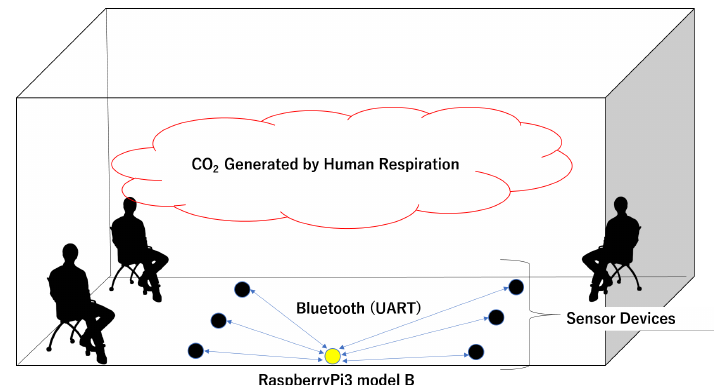
Figure 1. System concept diagram.